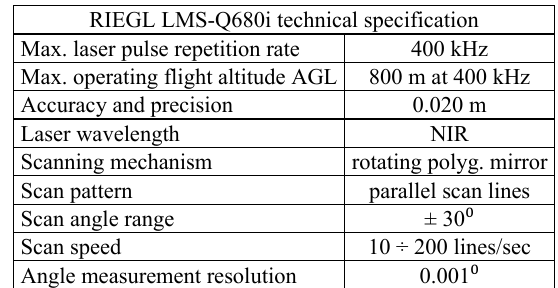
Table 2. RIEGL LMS-Q680i scanner